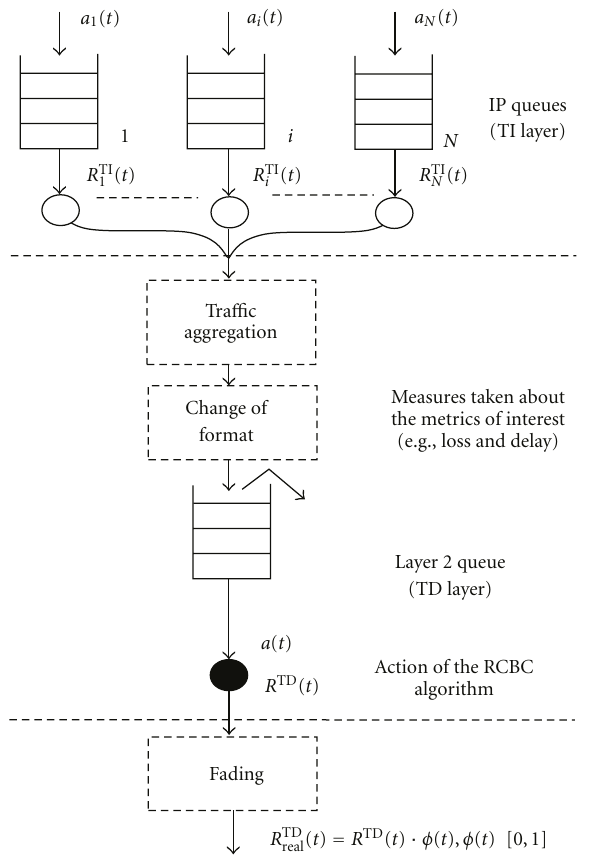
Figure 1: Cascade of queues model for adjacent layers.